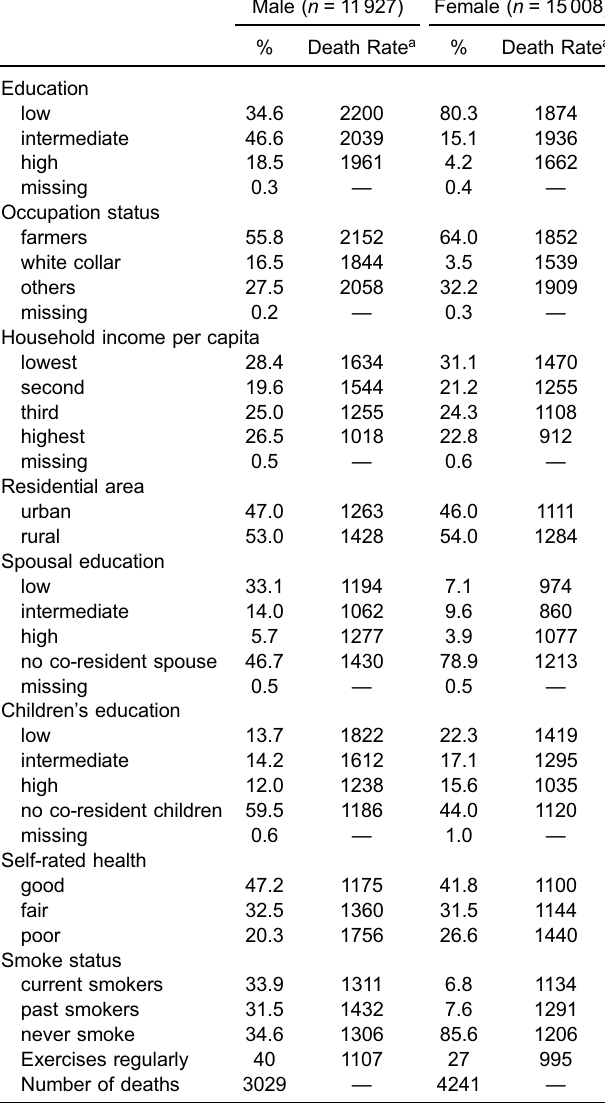
Table 1. Distributions of all variables and death rate of the